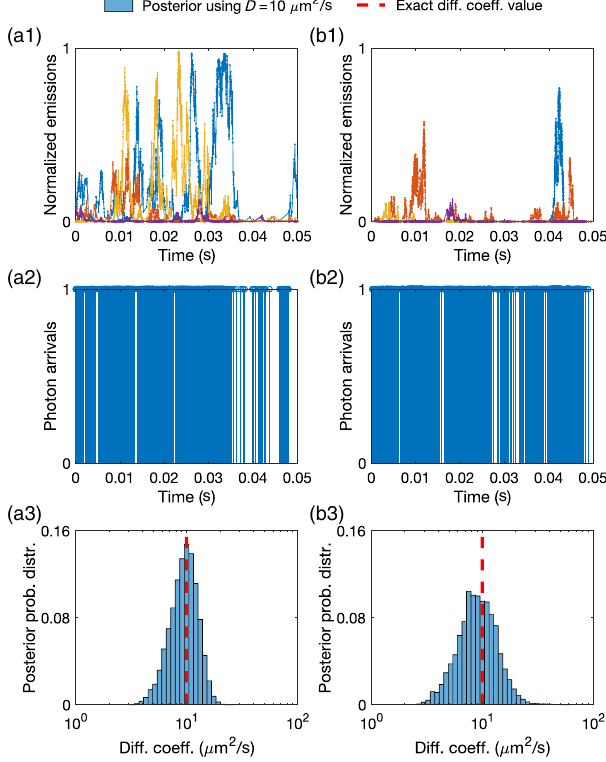
FIG. 15. FCS curves resulting from exceedingly short traces. Shown are autocorrelation curves G ð τ Þ of 5-TAMRA experi- mental traces, binned at 10 μ s, for 100 ms and ≈ 500 photon arrivals (a); 200 ms and ≈ 1000 photon arrivals (b); 300 ms and ≈ 3000 photon arrivals (c); 2 s and ≈ 15 000 photon arrivals (d); 30 s and ≈ 15 × 10 5 photon arrivals (e); 100 s and ≈ 15 × 10 6 photon arrivals (f). Even a visual inspection illustrates how poorly FCS applies on traces as sort as those analyzed by our BNP method.